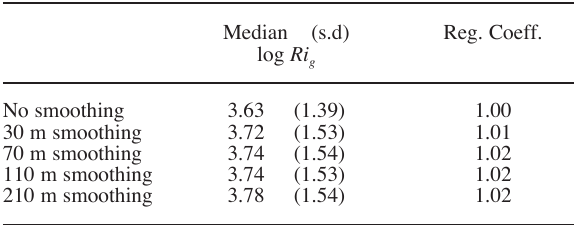
T ABLE 2. – Summary of results with the 36 ° N transect data. Medi- from the original and an and standard deviation values for log Ri g smoothed (30, 70, 110 and 210 m) data. Also shown are the regres- sion coefficients of the smoothed values with respect to the unsmoothed